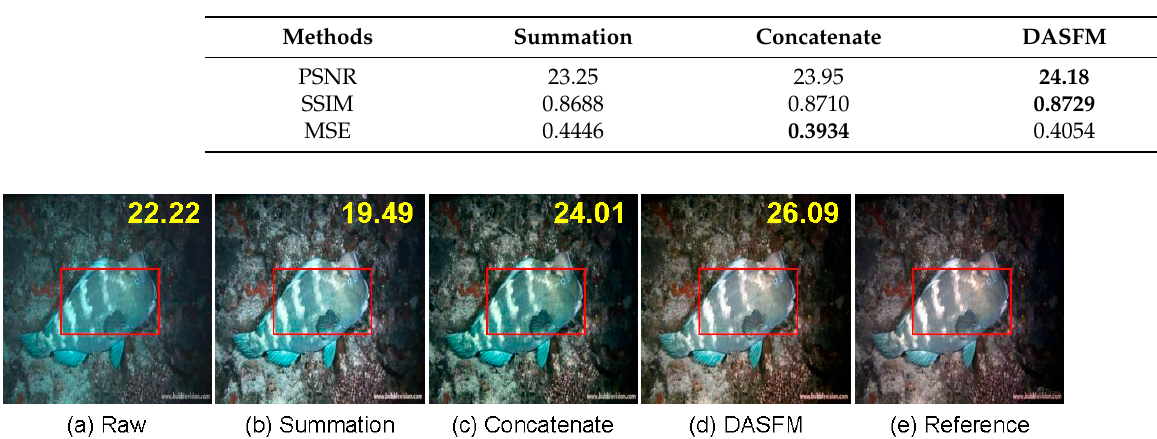
Table 5. Quantitative comparison results of ablation study of the dual-branch fusion methods in terms of PSNR (dB), SSIM, and MSE ( × 10 3 ) values. Bold values indicate the best results.